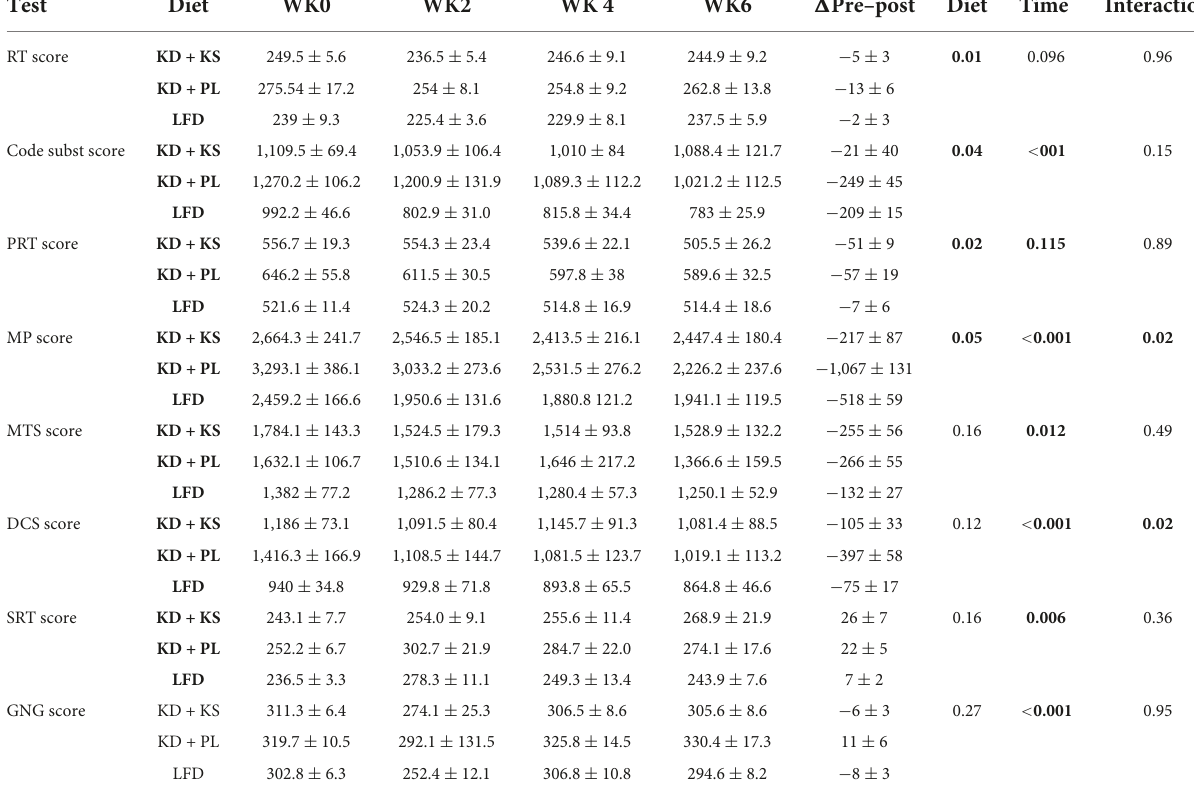
TABLE 3 Main effects and interactions for ANAM cognitive battery of tests.